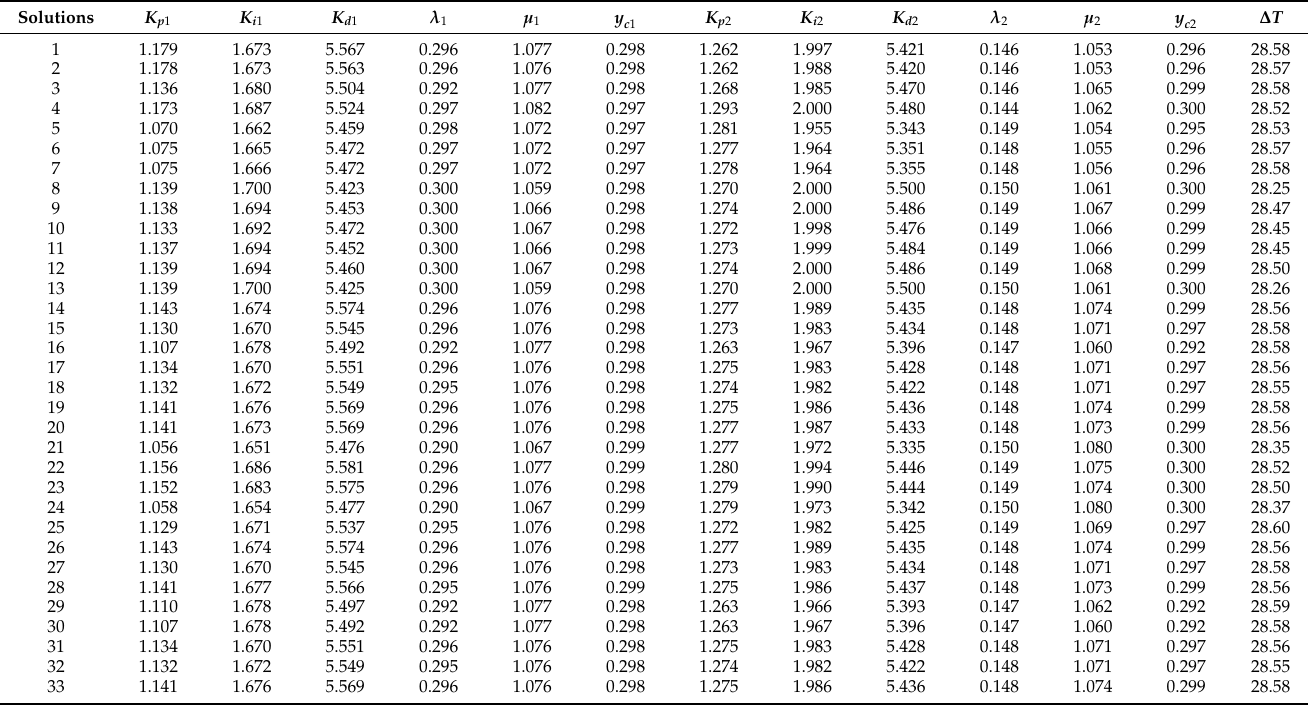
Table A2. Pareto archive under FOPID